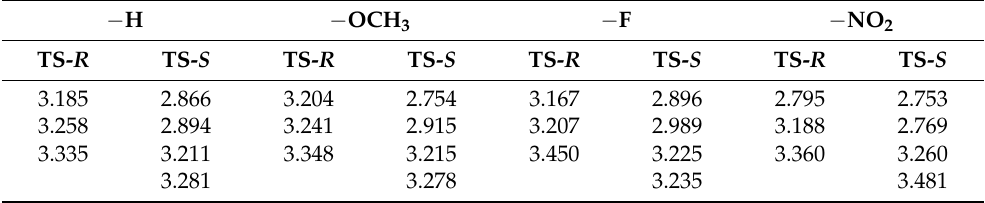
Table 1. Distances of C-H ··· π interactions (<3.5 Å) for TSs on the In-MOF in toluene. − H − OCH 3 − F − NO 2 TS- R TS- S TS- R TS- S